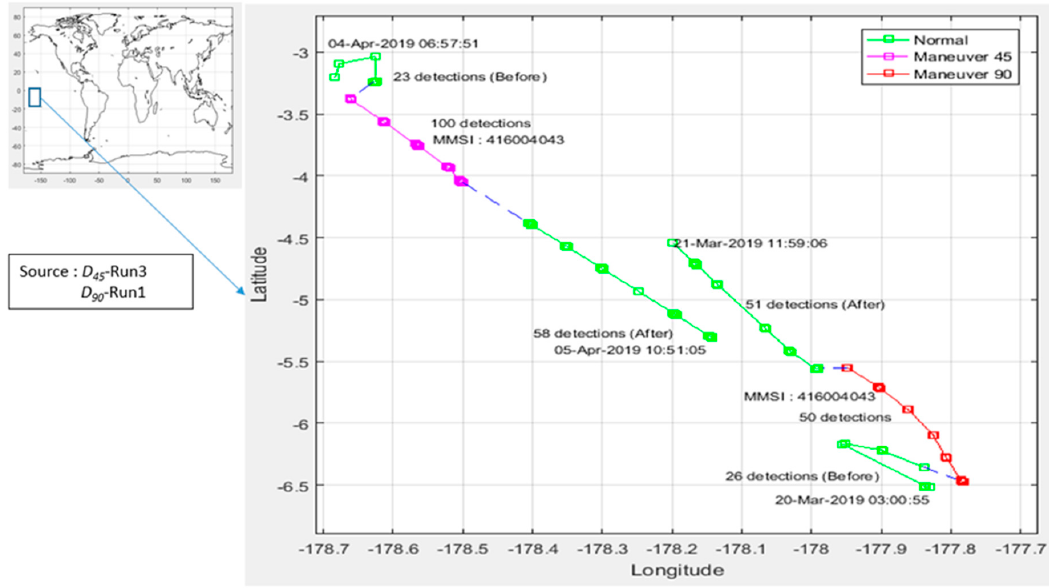
Figure 17. Class B sample of ship tracking detection.